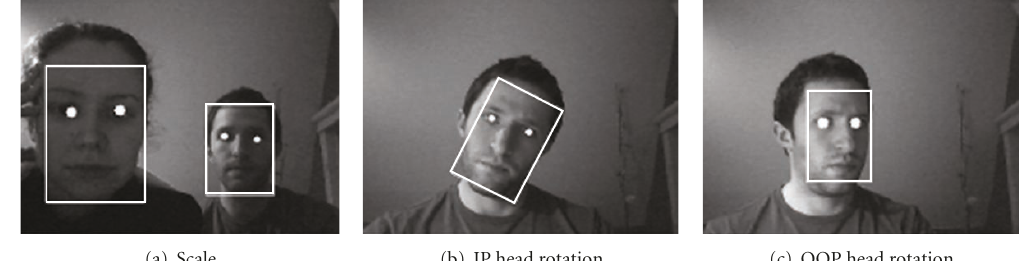
Figure 4: Face and eye detection under di ff erent situations.